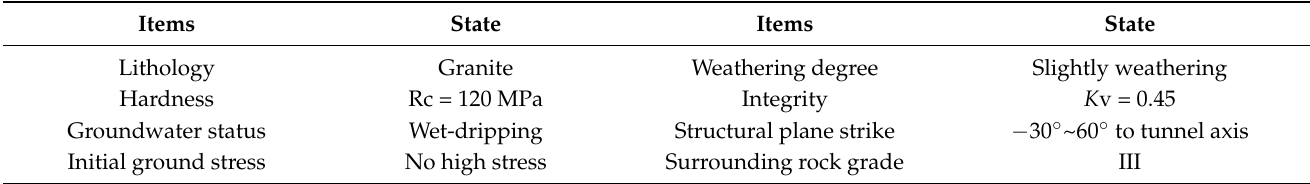
Table 4. Geology and supporting status of ZK4 + 085 section in large section.